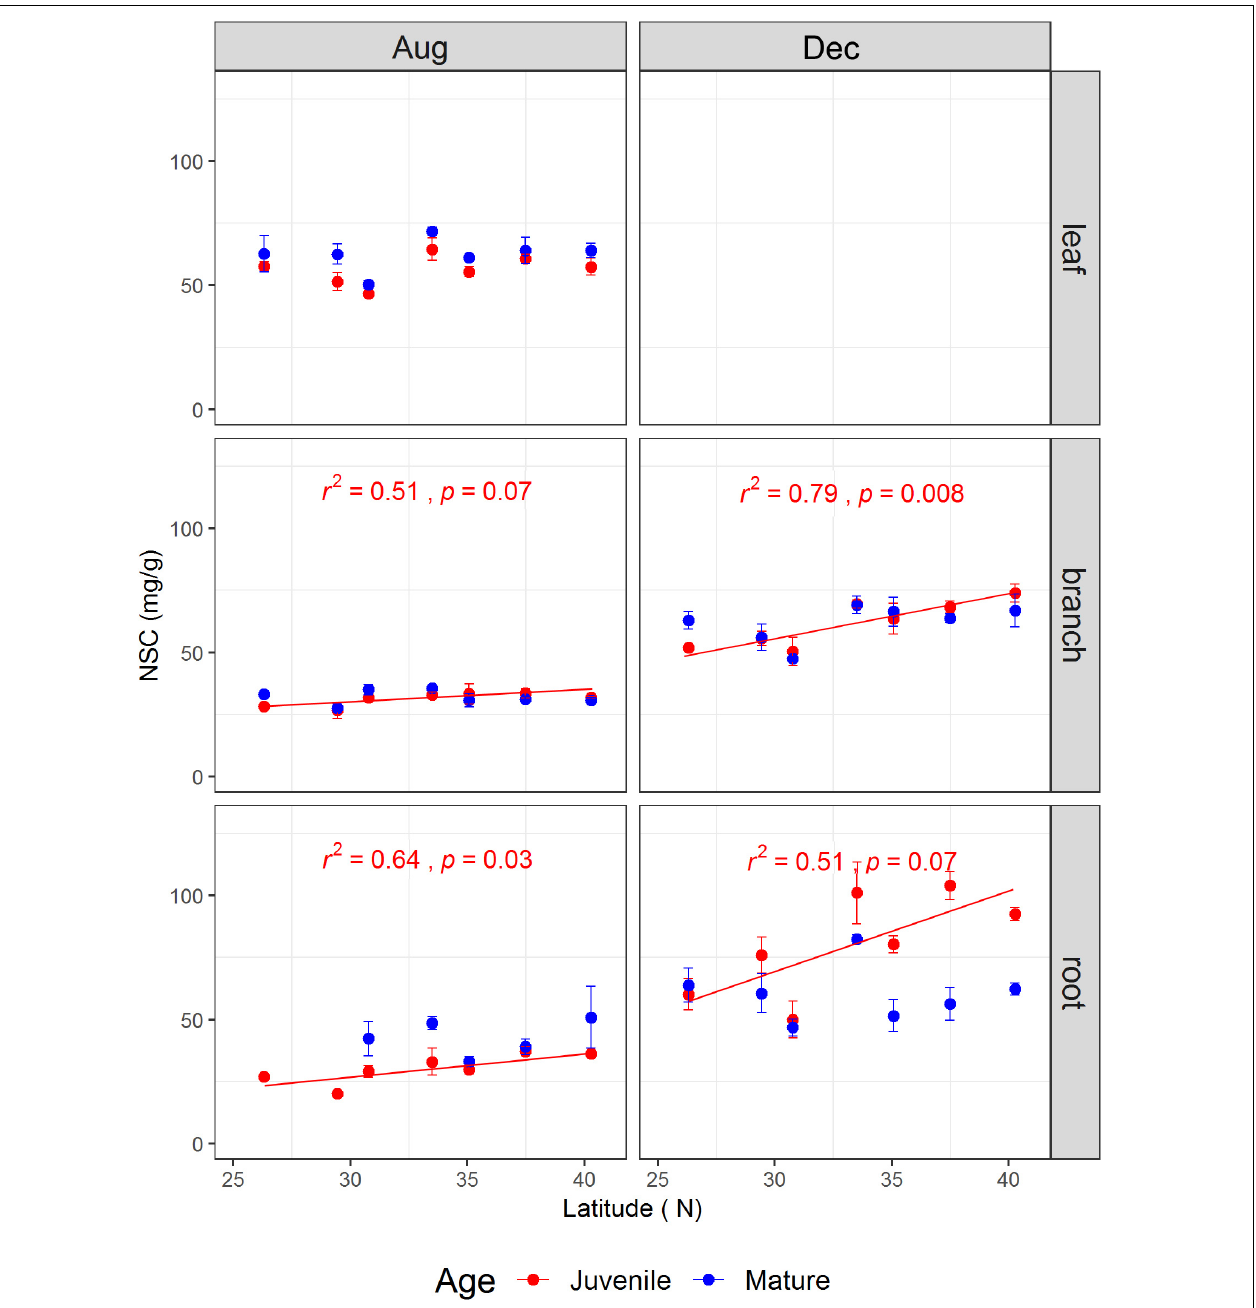
FIGURE 2 | The non-structural carbohydrate concentrations (mg/g) (mean ± se, n = 3) across life stages (juveniles vs. mature), tissues (leaf, branch, and fine root), and sampling seasons (growing season: Aug, 2014; and dormant season: Dec, 2014) along the latitudinal gradient. For each subplot, blue color denotes mature individuals and red denotes juveniles; fitted curves, determinant coefficients, and p -values of simple linear regression are